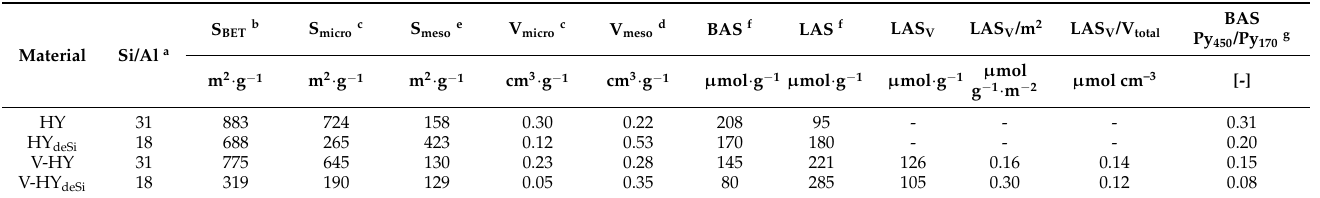
Table 1. Chemical composition and textural properties derived from N 2 physisorption. Acidity characteristics is derived from Py and CO adsorption FT-IR